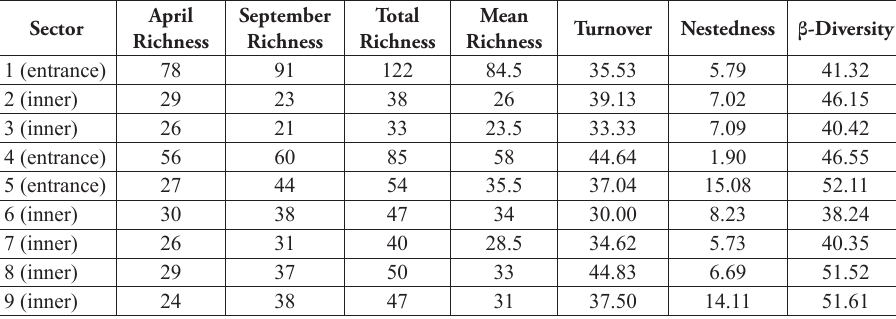
Table 2. Richness and Diversity values of the ten sectors in both sampling events. Sector